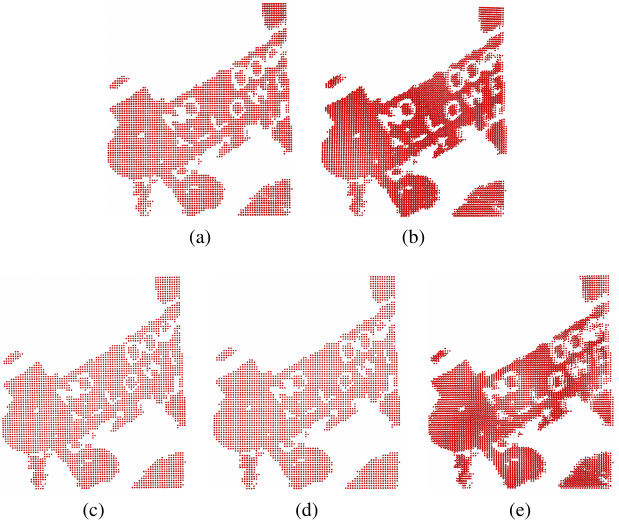
Fig. 19: Overlapping of the registered frames 1-4 by different algorithms. (a) Original ICP. (b) ICP-CTSF k = 50% . (c) Sparse ICP CTSF k = 5% . (d) Sparse ICP CTSF k = 10% . (e) Sparse ICP CTSF k = 75% .